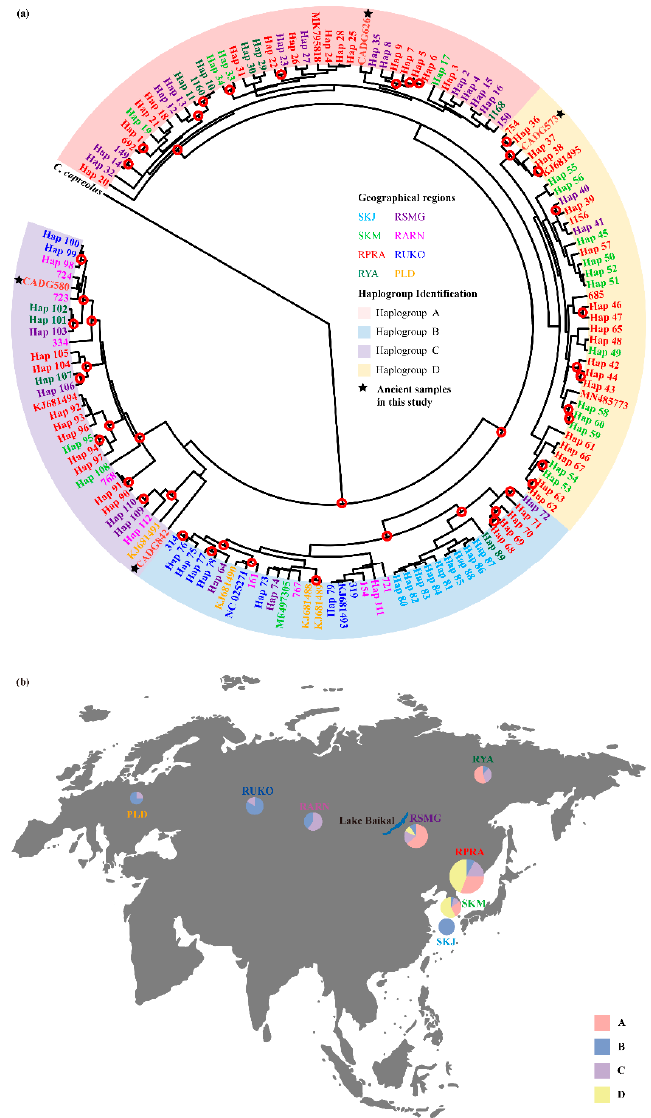
Figure 3. Phylogeographic distribution and Bayesian phylogenetic tree of the Siberian roe deer specimens with precise geographic localities (Data set 2, Table S2). ( a ) Bayesian phylogenetic tree of Siberian roe deer based on combined sequences of cyt b and the D-loop. Red hollow circles denote nodes supported by posterior probabilities over 95%. Tip labels are colored based on haplogroup. Colored letters correspond to different geographic regions that are markedin the same color. The four ancient samples from this study are shown by black stars. ( b ) Geographical distribution of the haplogroups revealed by Bayesian analysis. Circles are sized relative to frequency of the respective phylogenetic haplogroups (A, B, C, D). Lake Baikal is shown in blue in the bottom middle of the map. Regional abbreviations: Jeju Island in South Korea (SKJ); South Korea mainland (SKM); Primorsky Krai and Amur region of Russia and Northeastern China (RPRA); Yakutia in Russia (RYA); the Sokhondinsky Nature Reserve in the Trans-Baikal region of Russia, Buryatia in Russia, and Northern Mongolia (RSMG); Altay, Novosibirsk, Krasnoyarsk, Khakassia, and Irkutsk in Russia and Kazakhstan (RARN); the Urals, Kurgan, Orenburg, and Sverdlovsk in Russia (RUKO); Poland (PLD). The base map of global world (chart No. GS (2016)1566) was downloaded from the National Administration of Surveying, Mapping and Geoinformation of China (http://bzdt.ch.mnr.gov.cn, accessed on 19 May